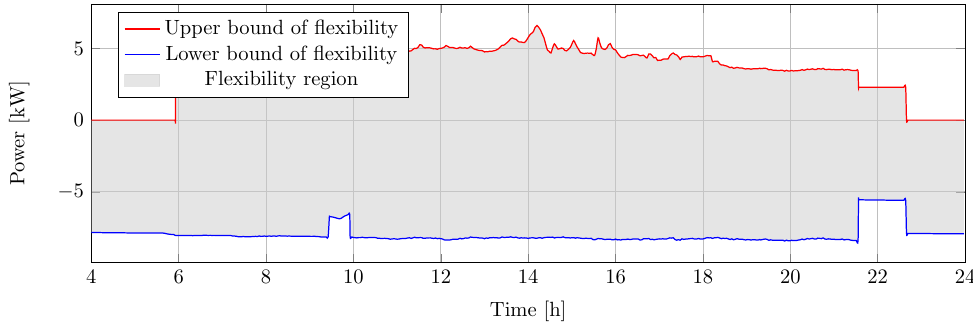
Figure 14. Available upward and downward flexibility for the summer cloudy day